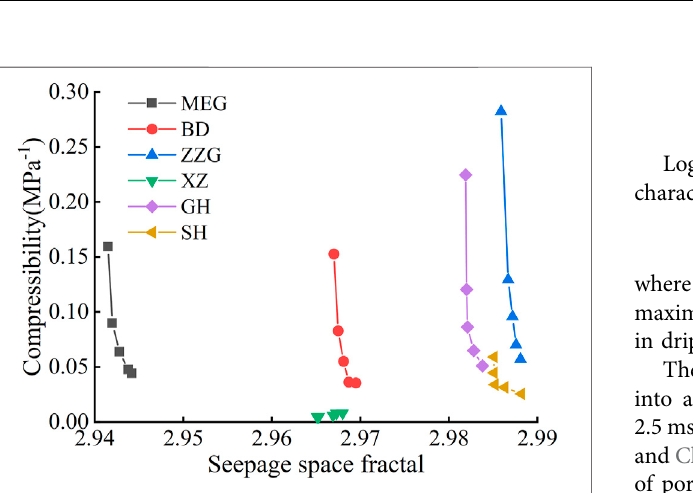
FIGURE 10 | Fractal dimension of samples under different con fi ning pressures (A) . Fractal dimension of adsorption pore; (B) . Seepage pore fractal dimension).